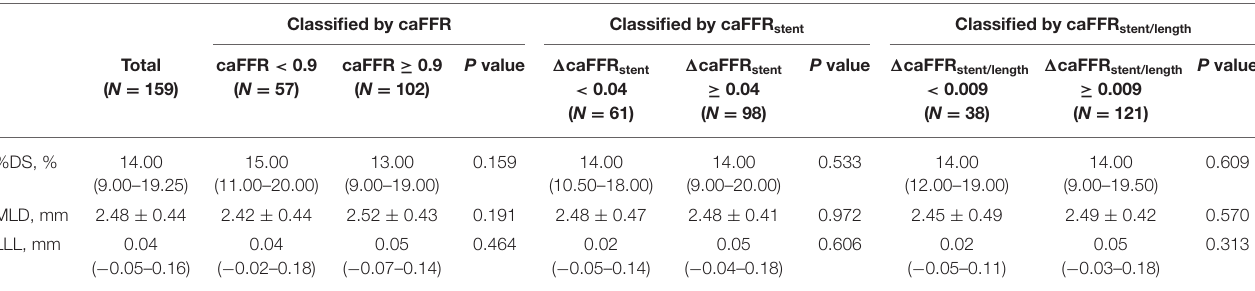
TABLE 3 | Quantitative coronary angiography at 9-month follow-up.